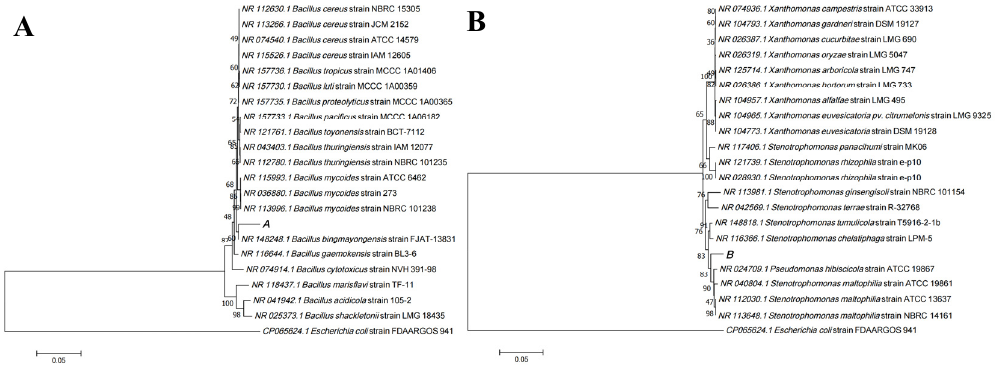
Figure 2. Neighbor-joining tree of strains based on 16s rRNA sequences, showing the respective homology of strain ( A ) and strain ( B ).